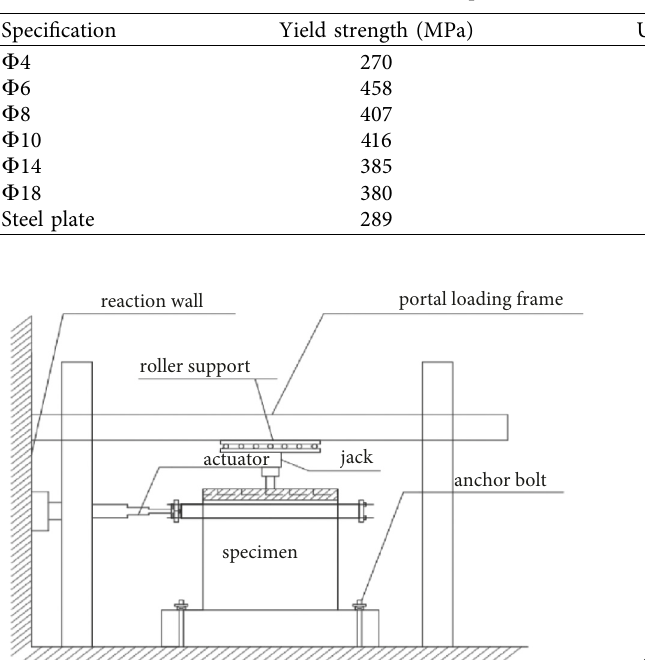
Table 2: Properties of reinforcing bars and the steel plate.